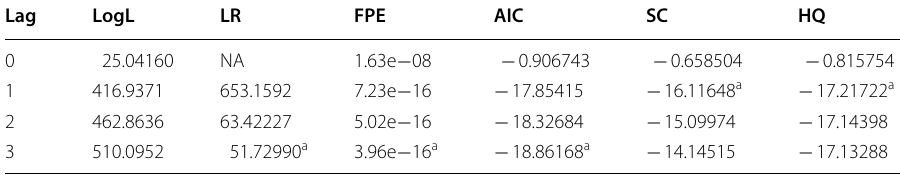
Table 5 VAR lag order selection criteria Source: Own computations